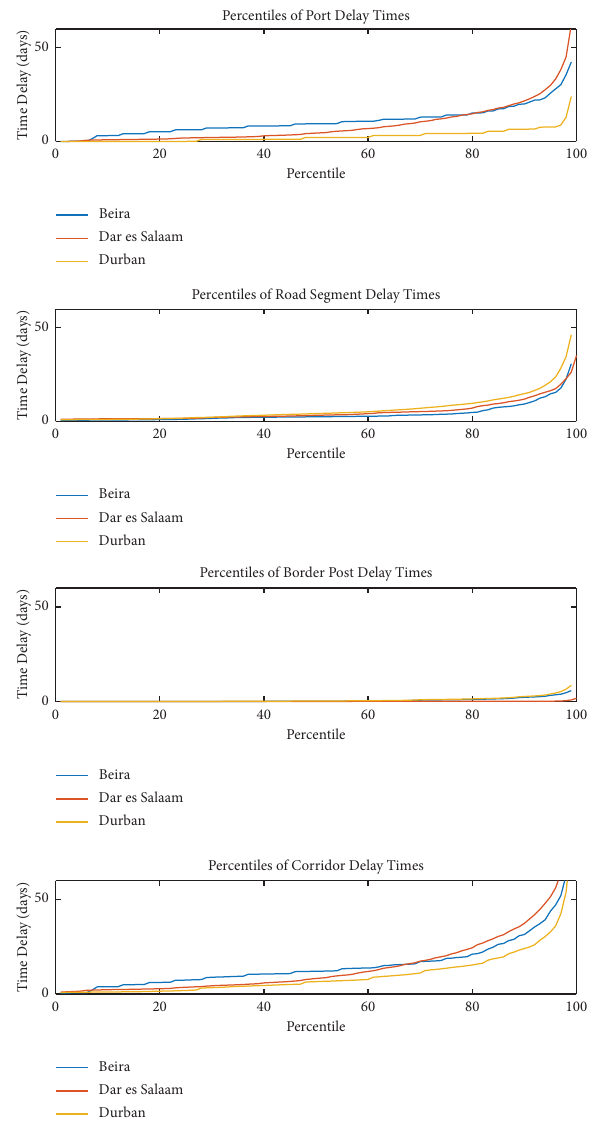
Figure 3: Percentiles of time delays for the 3 corridors and for each contributing corridor